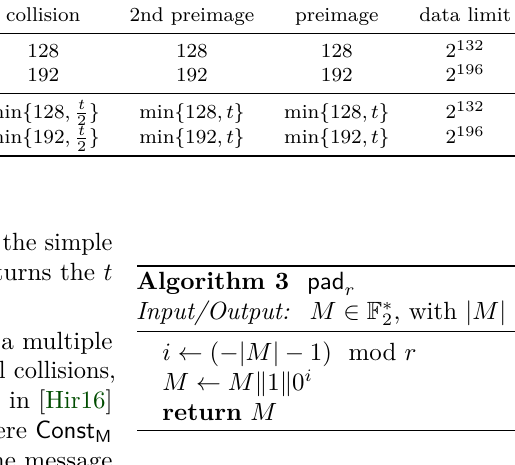
Table 2: The hashing instances with their security level in bit with regard to collision resistance and (second) preimage resistance and the limitation on the message size in bytes. For the security levels of the XOFs, we assume that 𝑡 is smaller than the allowed data limit.